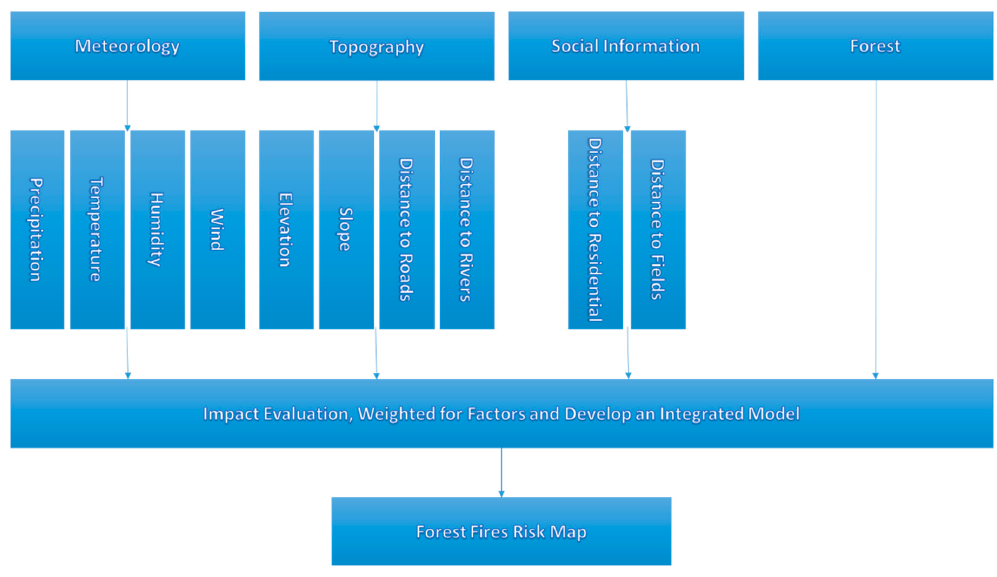
Figure 4. Process of developing a forest fire risk map.